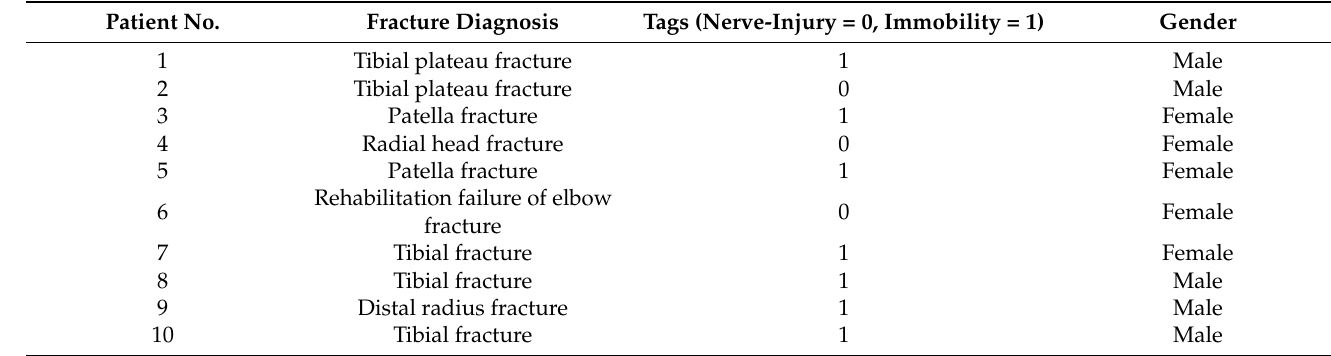
Table 1. Summary of the patients taken into